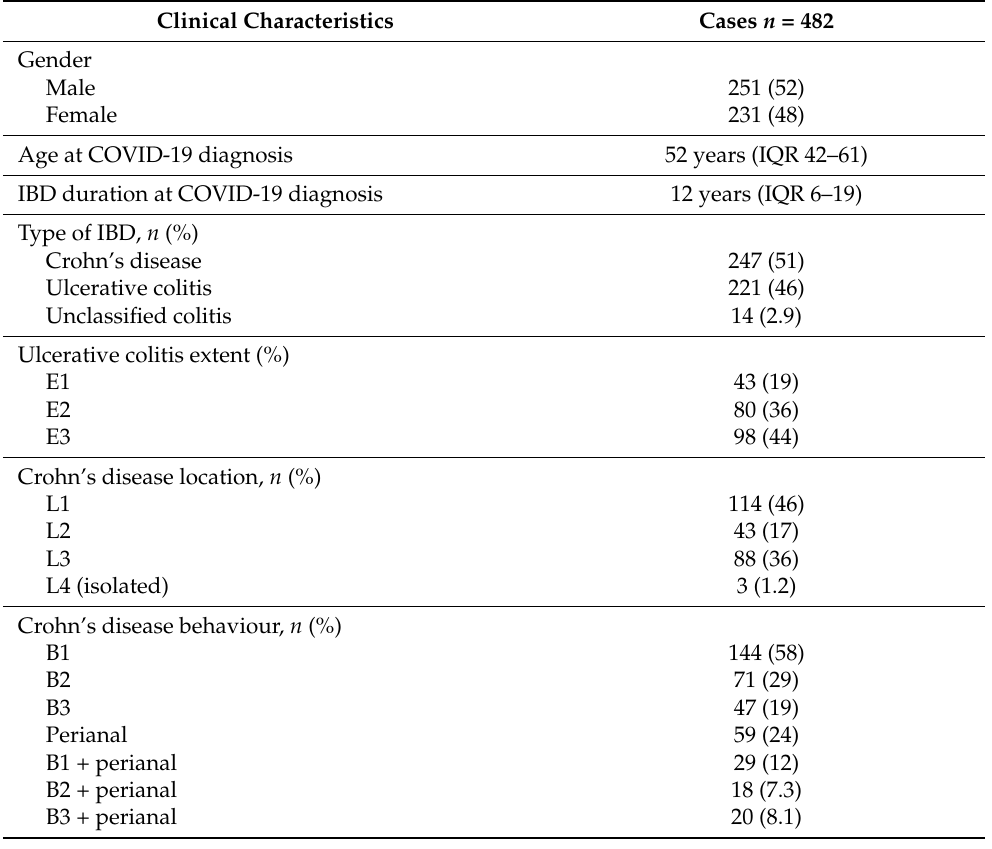
Table 1. Clinical baseline characteristics regarding inflammatory bowel disease with